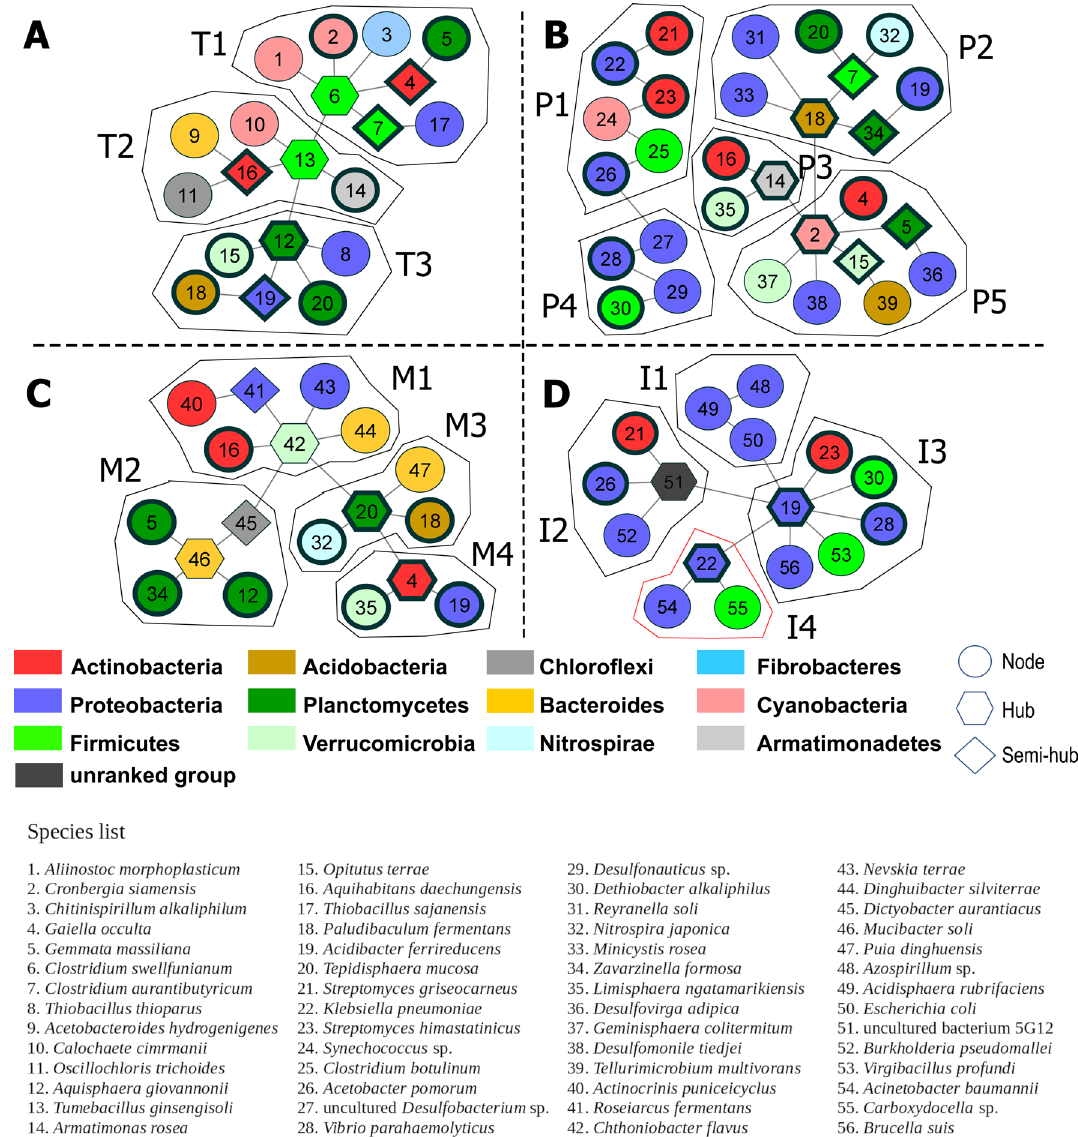
and their corresponding numbers in the